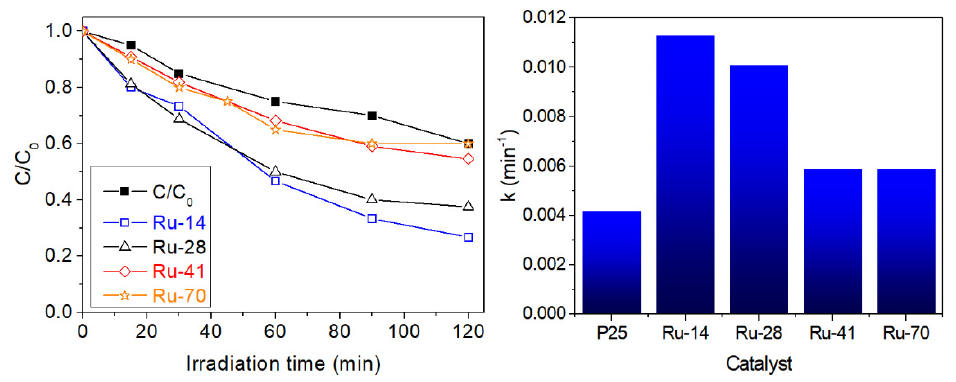
Figure 6. Formic acid oxidation with Ru/TiO 2 catalysts and TiO 2 -P25 as reference. Left panel: concentration decay with irradiation time. Right panel: apparent first-order kinetic constants fitted from semi-logarithmic plots.